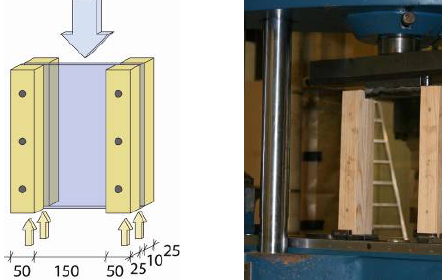
Figure 8a, b and c: Test setup with wood PMMA specimen.